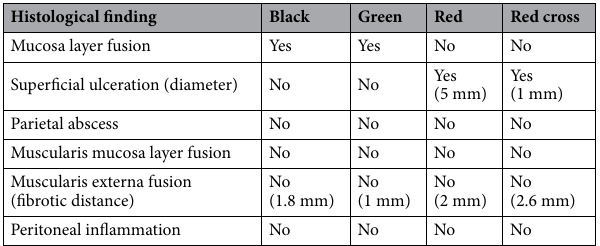
Table 1. Histopathological findings at the gastrojejunal anastomosis.